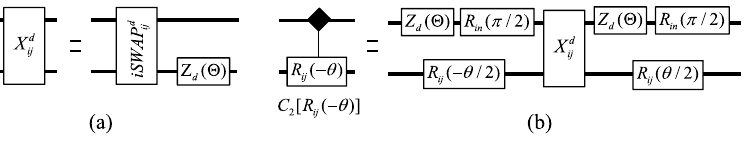
Figure 3. ( a ) The circuit decomposition of two-qudit gate X ijd defined in Eq. (15). ( b ) The circuit decomposition of two-qudit elementary gate C 2 [ R ij ( θ